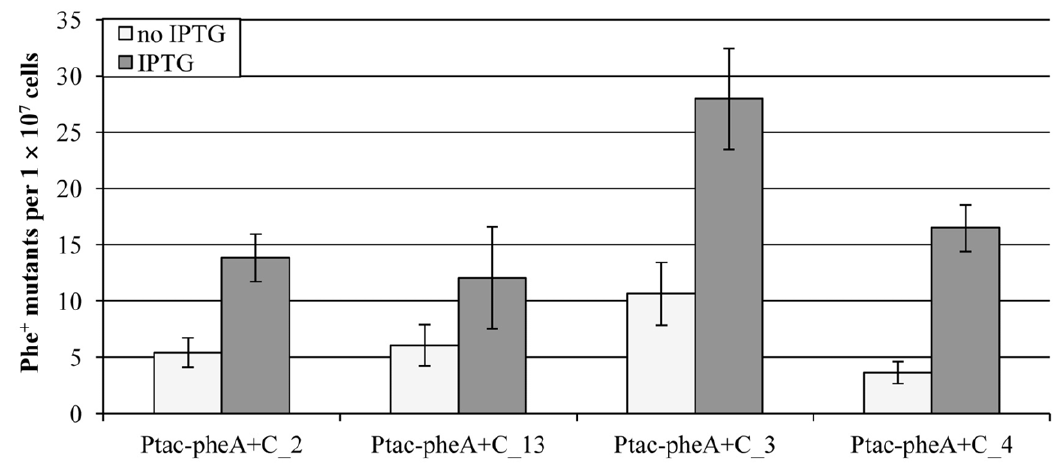
Figure 2. Effect of transcription of mutational target gene on mutation frequency. Influence of transcription was studied in growing bacteria. Average number of Phe + mutants accumulated per 1 6 10 7 viable cells is shown with 95%-confidence intervals. To compare the frequency of Phe + mutants in growing P. putida , bacteria were grown in the presence or absence of 1 mM IPTG and the number of mutants emerged onto phenol minimal plates on day 8 were counted. In total, at least 30 independent cultures were examined in three parallel experiments for each strain.